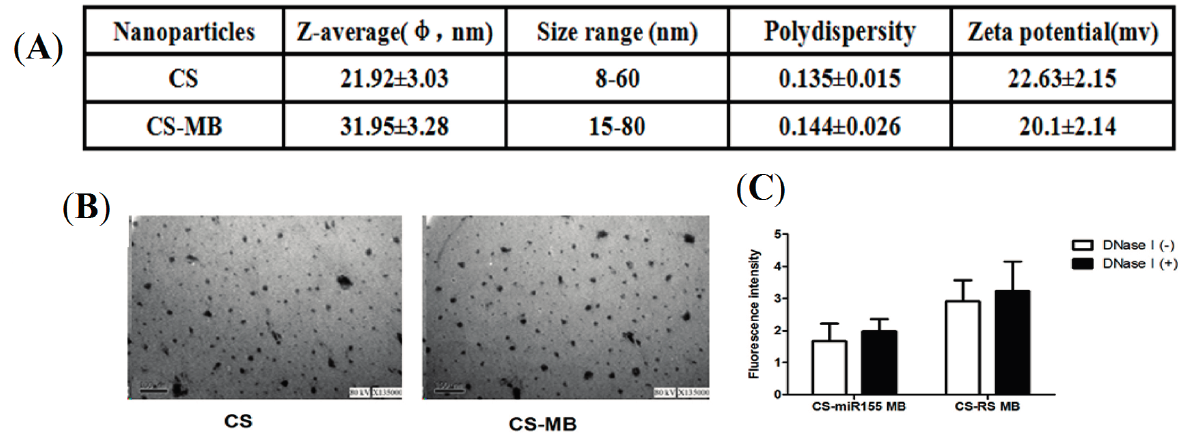
Figure 2. Physicochemical characteristics of CS-MB nanoparticals complexes. ( A ) The mean size, size range, polydispersity and zeta potential of CS and CS-MB. (n = 3). ( B ) TEM images of CS and CS-MB. Scale bar = 100 nm. ( C ) Fluorescence intensity of CS-MB with or without DNase I (n =